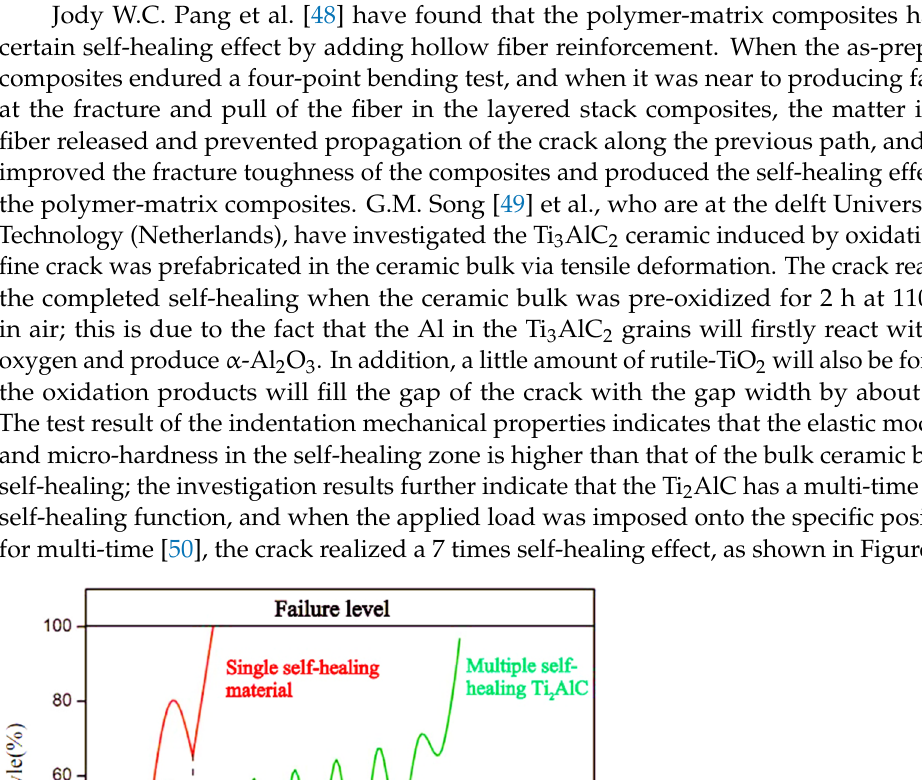
Figure 4. Schematic of the self-healing system used in the matrix of a woven fiber-reinforced composite [47].